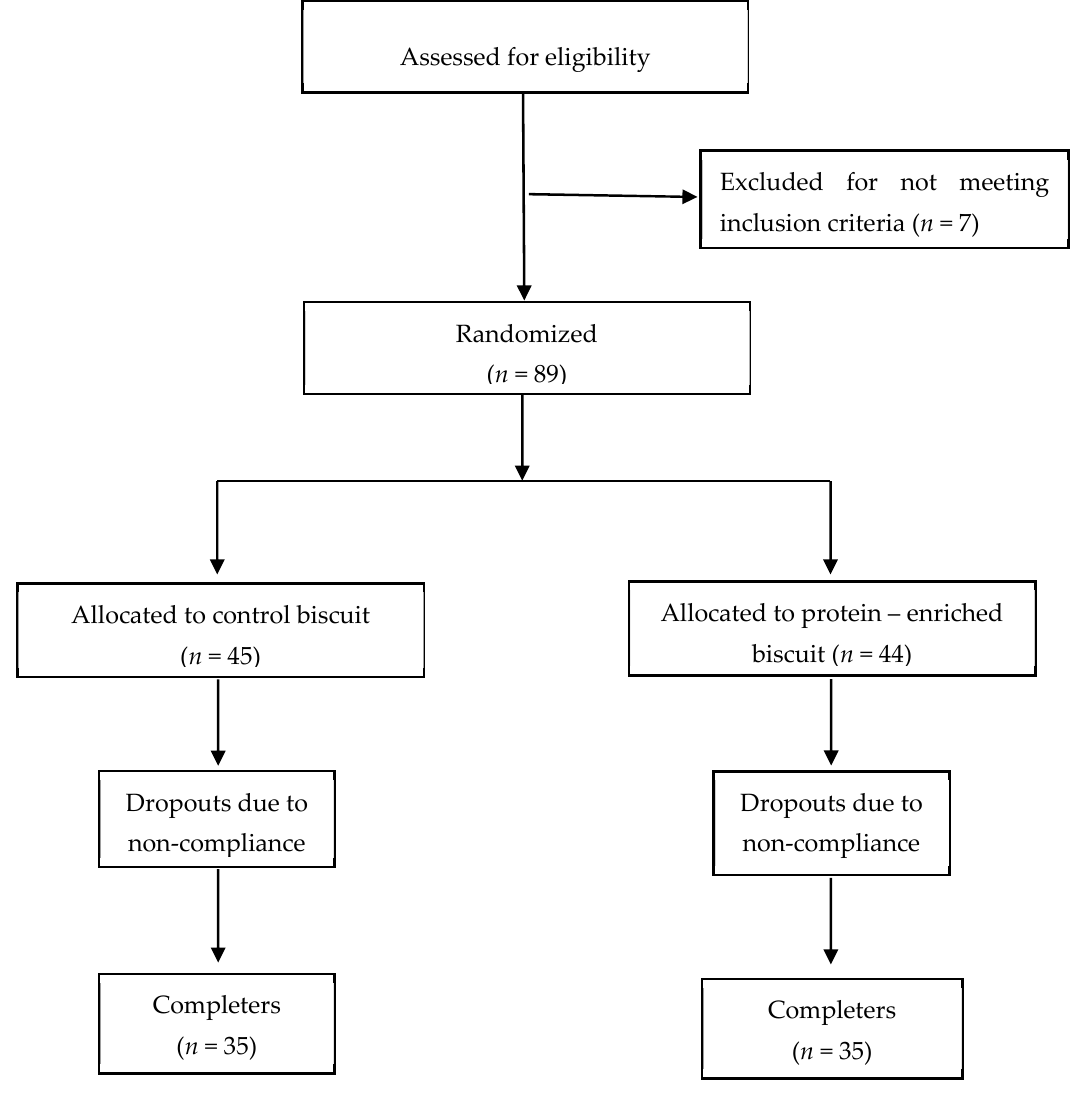
Figure 1. Flow chart of the study.